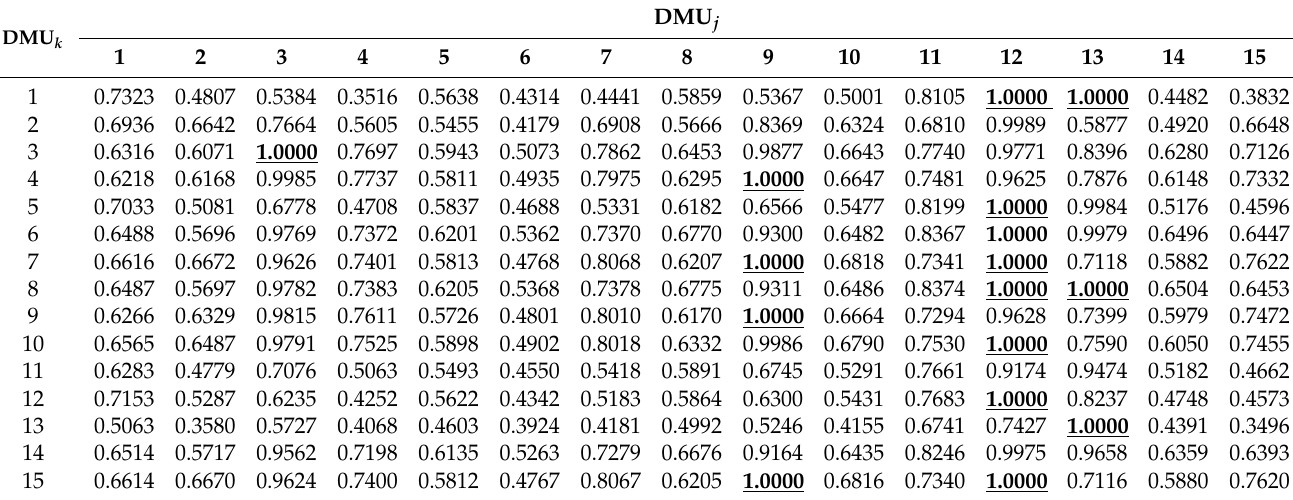
Table 4. Cross-efficiency matrix for 15